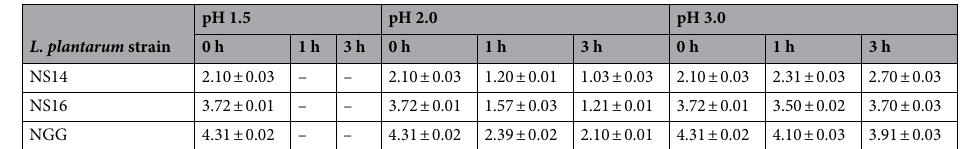
Table 3. Viable cells (log 10 cfu/ml) of L. plantarum strains in MRS broth at different pH and time intervals. The mean of three values ± SD are presented.